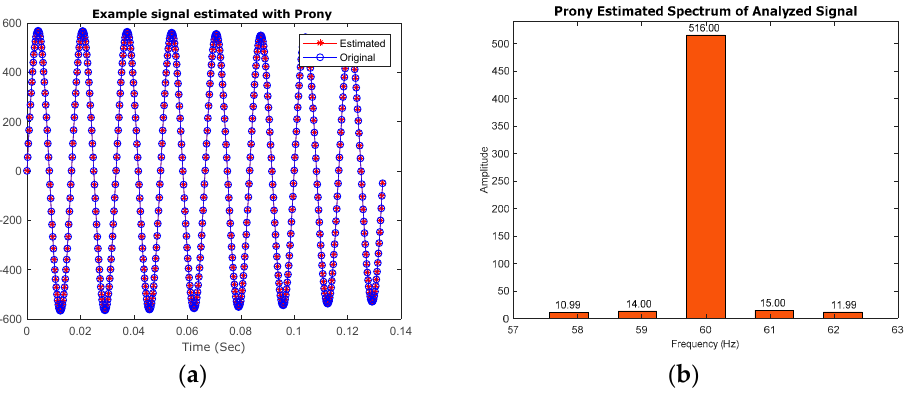
Figure 4. Simulated example signal validation. ( a ) Estimated and original signal comparison. ( b ) Estimated Prony spectrum. Table 3. Simulated example, Prony estimated signal parameters.